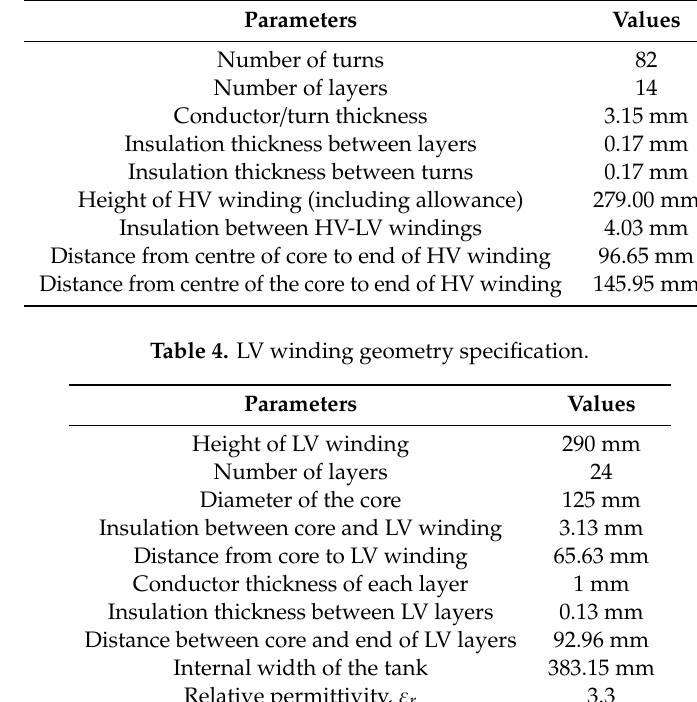
Figure 5. ( a ) Overall cross-sectional; ( b ) front cross-sectional view of the winding for a single phase. Table 3. HV winding geometry specification.